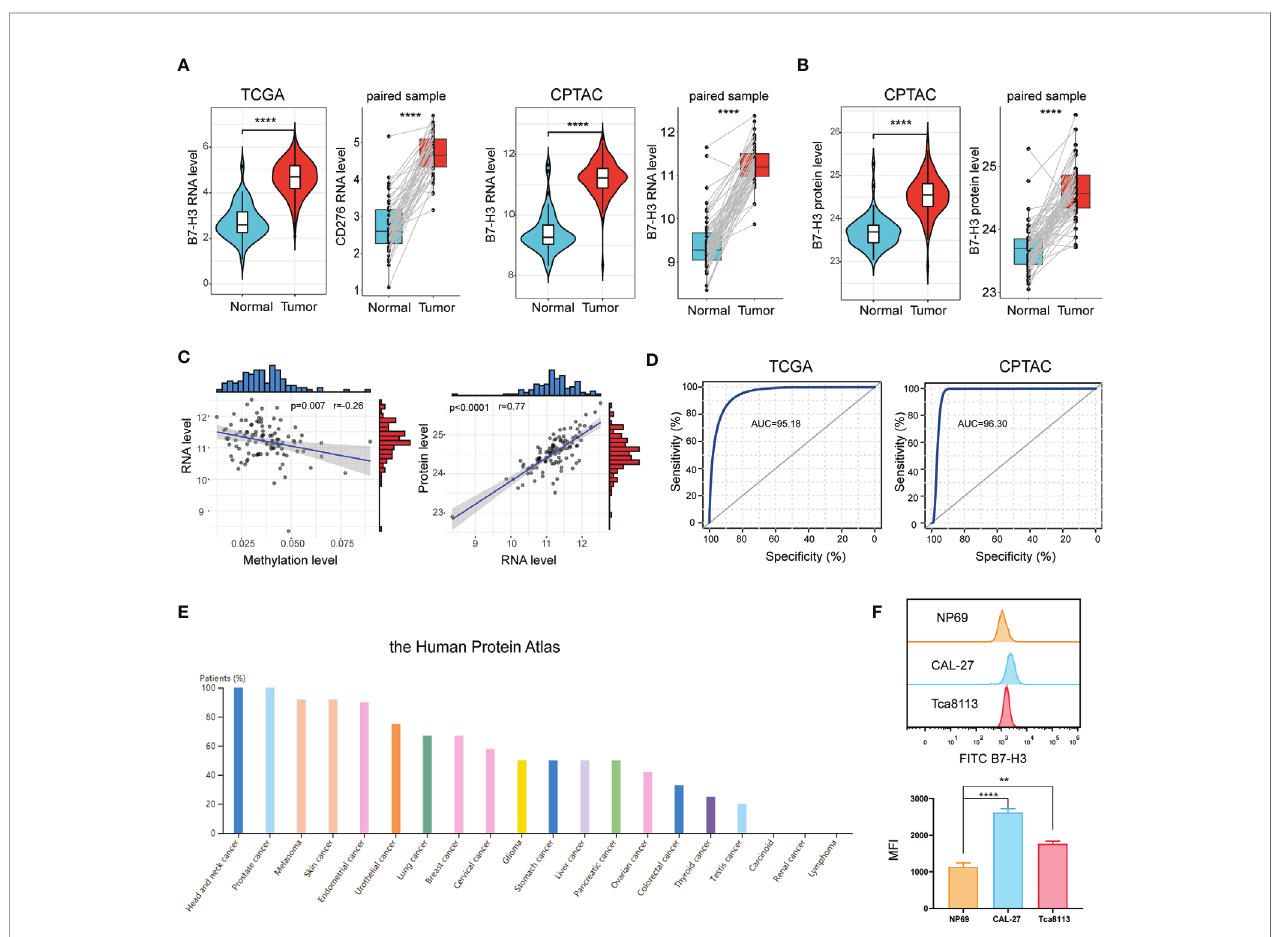
FIGURE 1 | B7-H3 is overexpressed in HNSCC. (A, B) Violin plot and box plot present the differentially expressed B7-H3 between HNSCC and normal sample; (C) Scatter plots show the association of B7-H3 RNA expression with protein expression and DNA methylation; (D) ROC curves indicate the diagnostic value of B7-H3; (E) The protein expressions of B7-H3 in different tumors; (F) Expression level of B7-H3 in NP69, CAL-27 and Tca8113; **P < 0.01 & ****P <